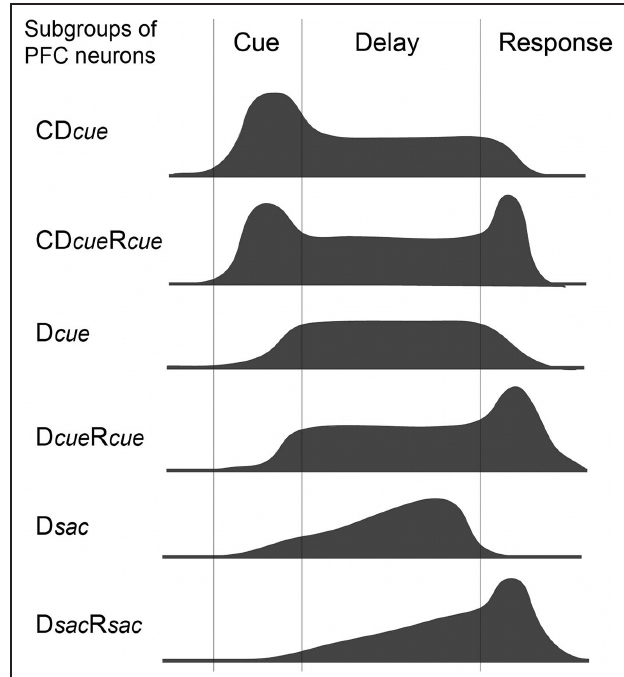
FIGURE 3 | Schematic drawings of the temporal profiles of activity for six groups (D cue , D sac , CD cue , D cue R cue , D sac R sac , and CD cue R cue ) of DLPFC neurons (adapted from Takeda and Funahashi (2007))